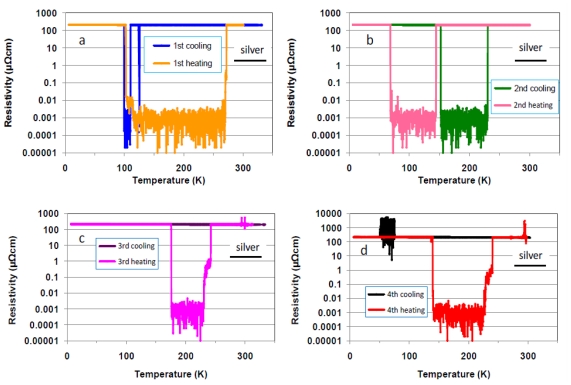
The temperature dependence of the resistivity of polished (Ni0.39Nb0.26Zr0.35)78.8H21.2 glassy alloy in the 1st cooling and heating runs (a); the 2nd runs (b); the 3rd runs (c); and the 4th runs (d).